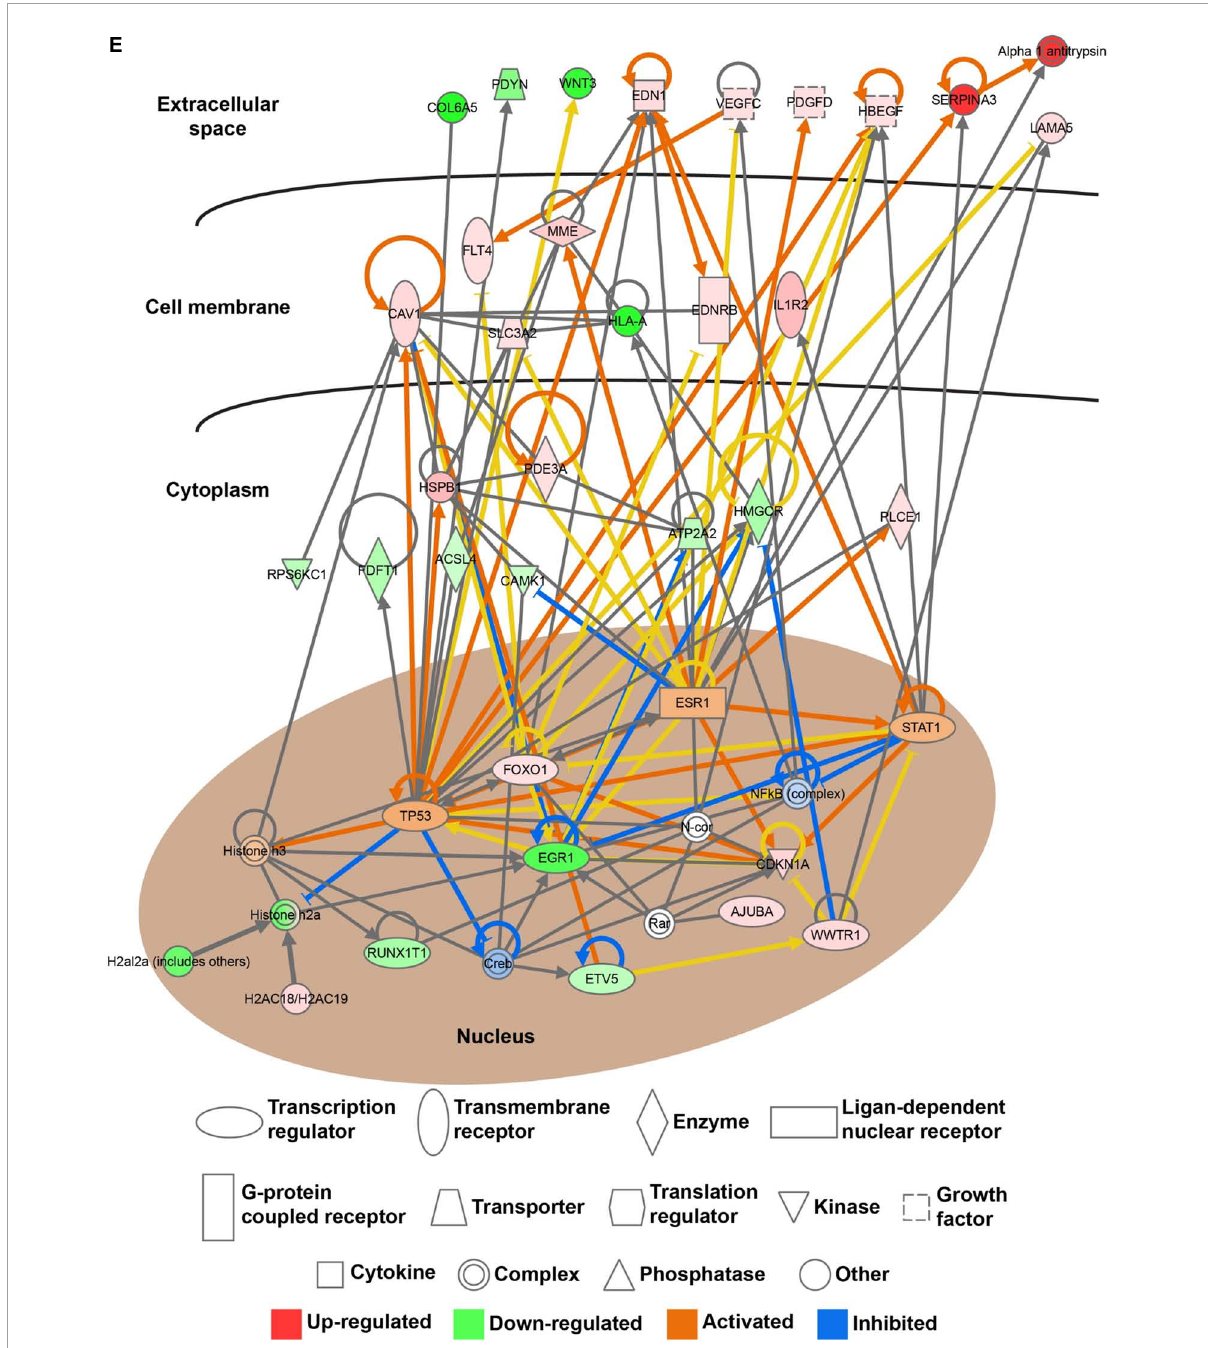
FIGURE3 Beneficial effect of laminarin in MCAO model. (A) Volcano plot showing the differential gene expression in the brain of MCAO model caused by laminarin treatment. Blue dots represent downregulated genes and red dots represent upregulated genes. Gene ontology enrichment analysis highlighted the involvement of laminarin in biological processes related to (B) development of blood vessel, (C) brain functions, and (D) cell signaling pathways. The size of the bubble represents the number of genes and the color of the bubble represents the significance of the biological process. (E) Gene networking of IPA demonstrated the involvement of growth factors, transporters, transmembrane receptors, G-protein coupled receptors, enzymes, kinases, and transcription regulators in the recovery roles of laminarin in ischemic stroke. Red figures represent the upregulated genes and green figures represent downregulated